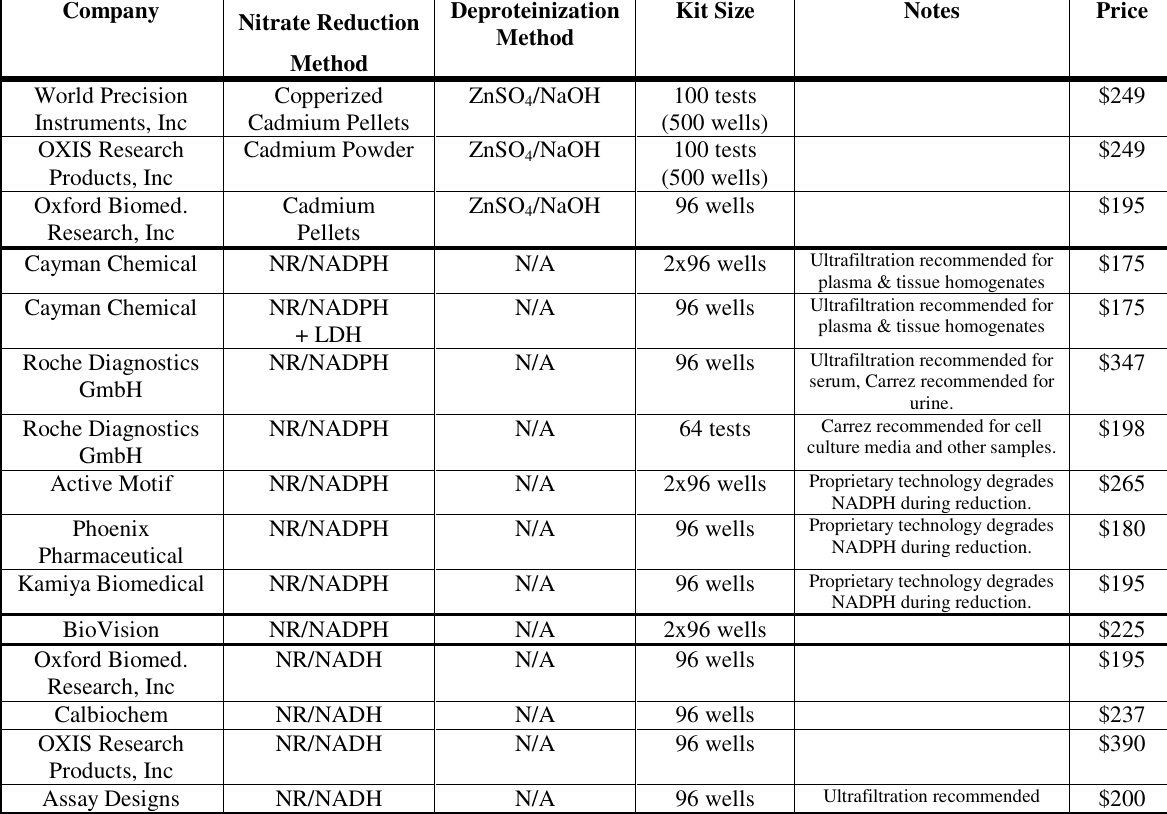
Table 1 . Commercial Griess Reaction assay kits used for biological